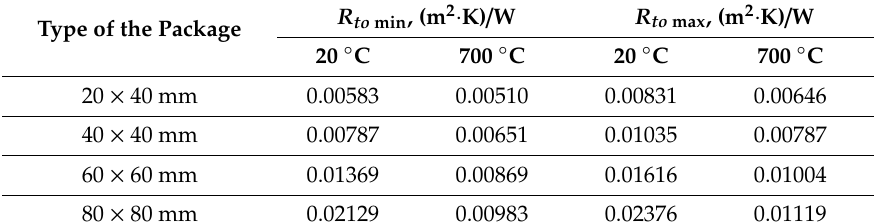
Table 2. Minimal and maximal values of resistance R to obtained for 20 and 700 ◦ C.